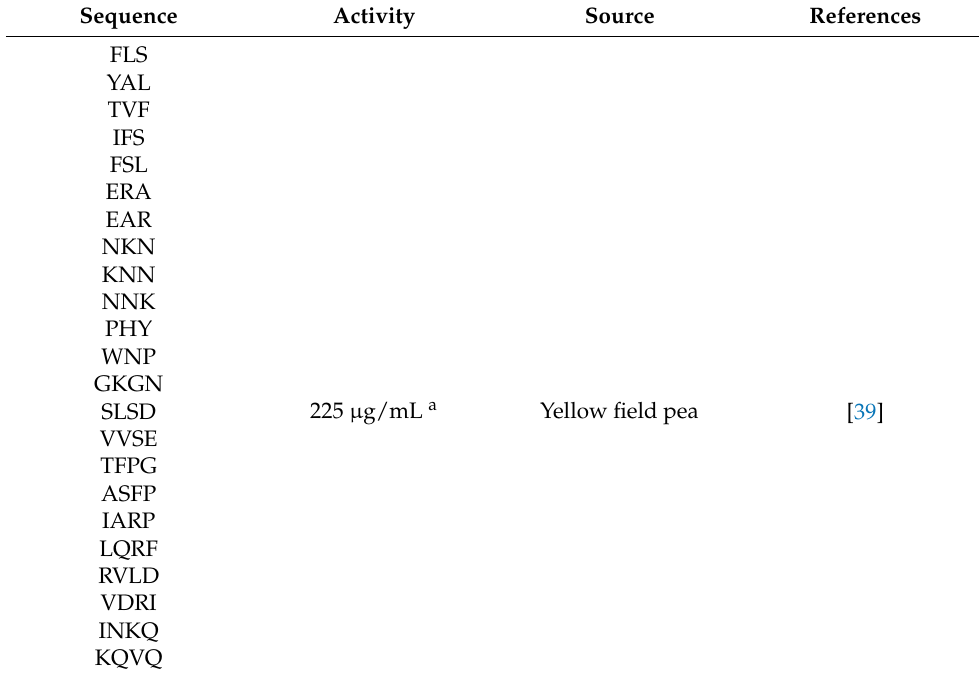
Table 1. List of tri- and tetra-peptides with reported inhibitory activity against pancreatic alpha amylase.